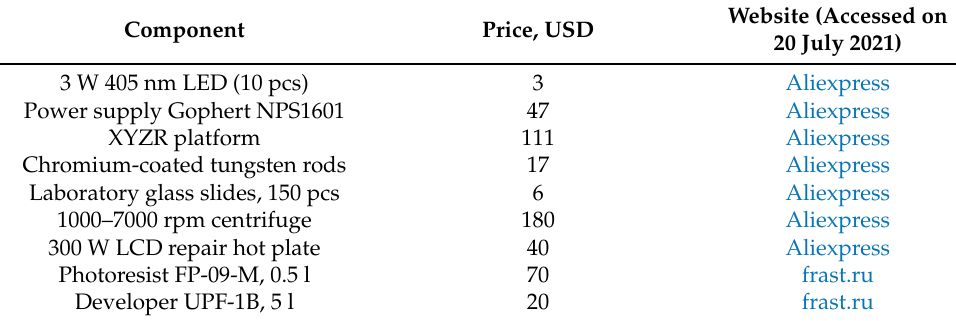
Table 1. Components of the micromask-lithography